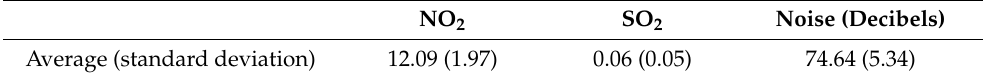
Table 1. Average air pollution and noise pollution measurement results.